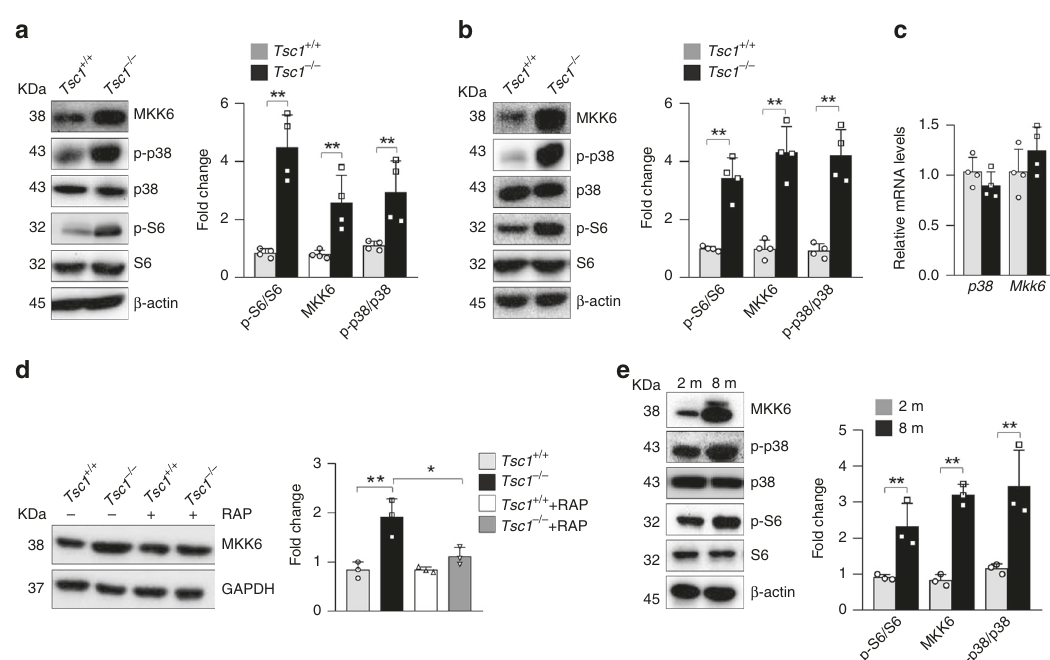
Fig. 4 Tsc1 de fi ciency increases MKK6 protein levels in an mTORC1-dependent manner. a , b Western blot results showed that the levels of MKK6 and activation of p38 MAPKs were increased in villus samples of Villin-Cre; Tsc1 f/f mice ( a ) and Tsc1 -de fi cient organoids ( b ) compared with those in controls. Right panels: quanti fi cation data (mean ± SEM). N = 4 mice for a and 3 for b . ** P < 0.01 (determined using Student ’ s t test). c Tsc1 de fi ciency did not signi fi cantly affect the mRNA levels of Mkk6 in crypt samples. The total RNA was isolated from the crypt samples, converted into cDNA, and then used for quantitative PCR analysis. N = 4 mice per group. d Tsc1 de fi ciency led to an increase in radio-labeled methionine incorporation into MKK6, which were suppressed by RAP. Primary enteroblast cultures were pulse-labeled with 35 S Met and Cys for 1 h. The cells were collected, and MKK6 was immunoprecipitated and fractionated onto SDS-PAGE gels, which were dried; the signals were detected with a PhosphorImager. Right panels: quanti fi cation data (mean ± SEM). N = 3 mice per group. * P < 0.05 (determined using Student ’ s t test). e Western blot analysis revealed that crypt samples from 8- month-old Lgr5-GFP-CreERT;Tsc1 f/f mice showed increases in MKK6 expression, p38 MAPK activation, and mTORC1 activation compared with those from 2-month-old mice. Right panels: quanti fi cation data (mean ± SEM). N = 3 per group. * P < 0.05 (determined using Student ’ s t